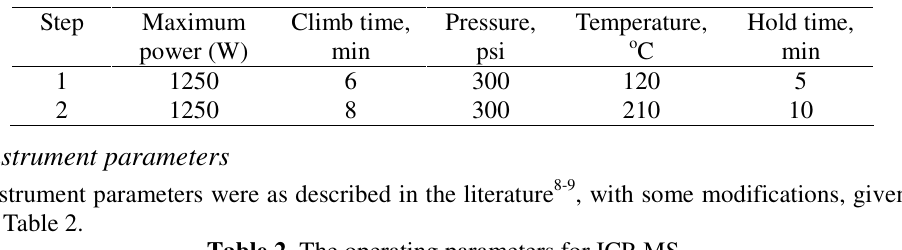
Table 1. Microwave digestion temperature control program